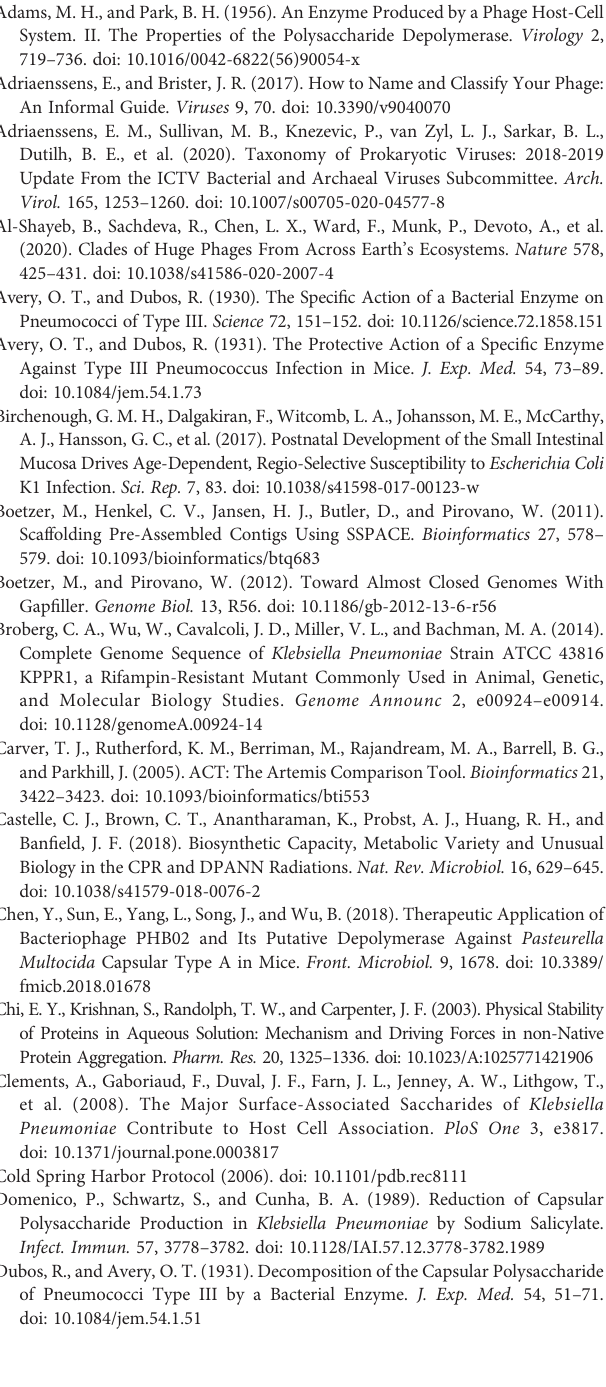
Supplementary Table 3 | Published protein sequences of phage-encoded K. pneumoniae depolymerases employed for BLASTX search of Thai K. pneumoniae phage genomes. Supplementary Data Sheet 1 | Sequences of plasmids used in this